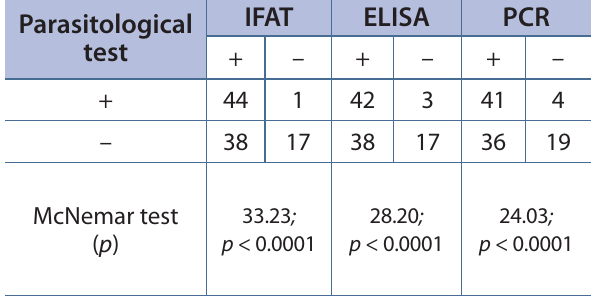
lymph nodes. Despite this, 77 dogs from Bauru were positive by PCR LIN, of which 36 of them (46.75%) did not present any amastigote form in their lymph Table 3. Number of animals positive and negative by IFAT, ELISA and PCR compared with the direct parasitological test and p values (McNemar test) Parasitological test